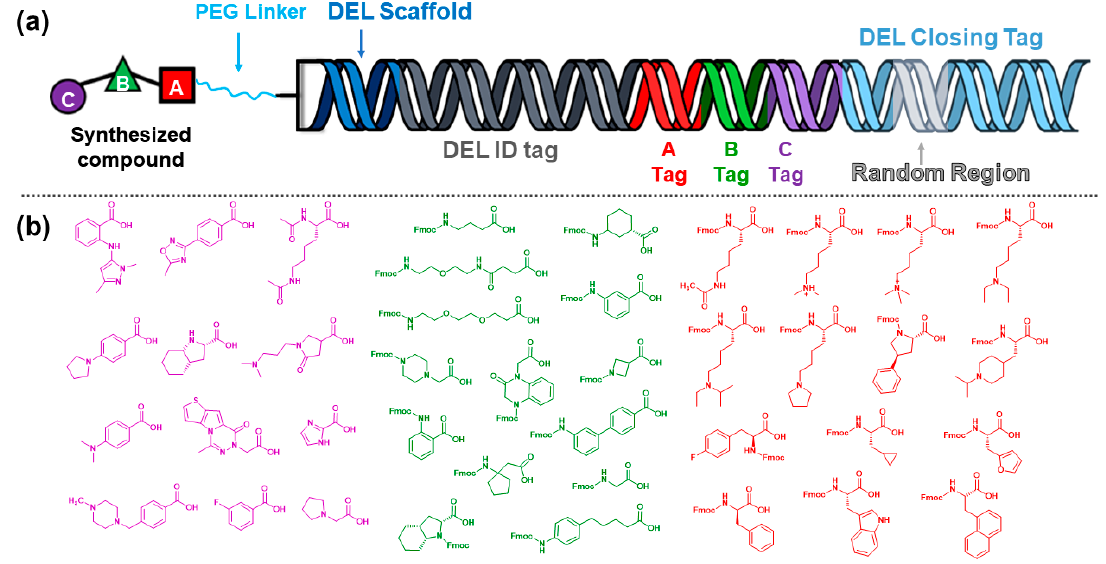
Figure 3. ( a ) A single barcode representation of a library member with important components identified. ( b ) Examples of building blocks utilized in the library described (UNCDEL003).